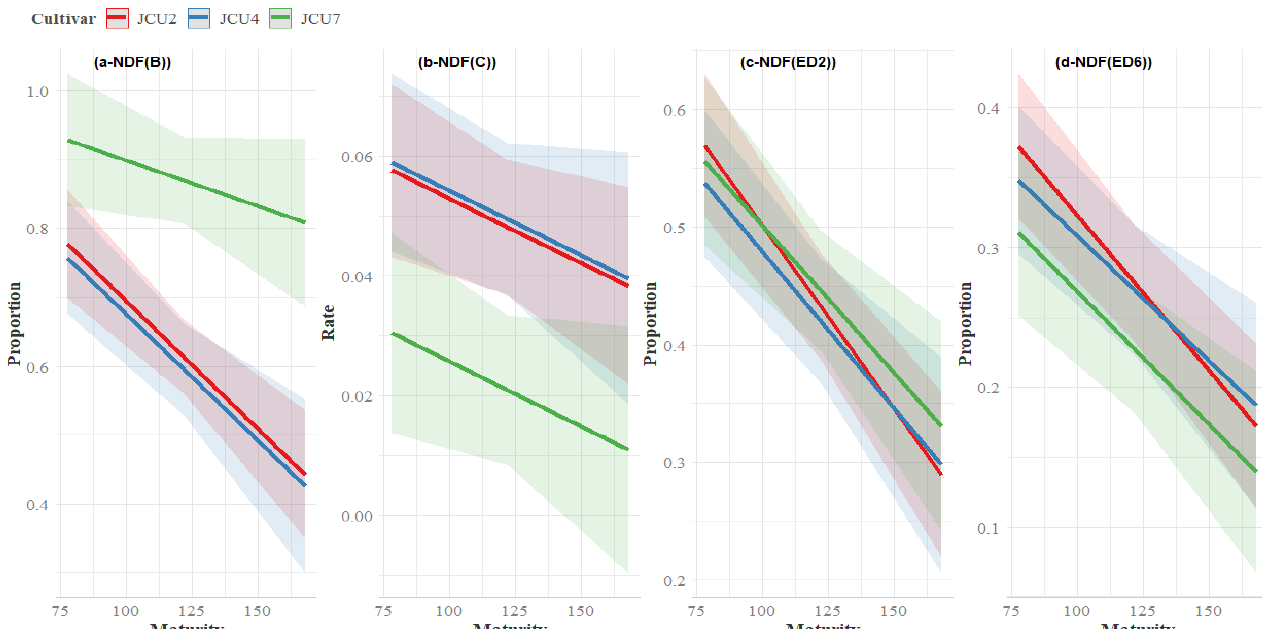
Figure 6. Effect plots for the change in in situ neutral detergent fibre (NDF) degradation of D. virgatus (JCU2), D. bicornutus (JCU4) and D. leptophyllus (JCU7) with maturity. ( a ) B; potentially degradable fraction, ( b ) C; rate of degradation of fraction B, ( c ) ED2; effective NDF degradability with particle outflow rate of 2%/h and ( d ) ED6; effective NDF degradability with particle outflow rate of 6%/h. Cultivar by maturity interactions were not significant ( p ≥ 0.12).